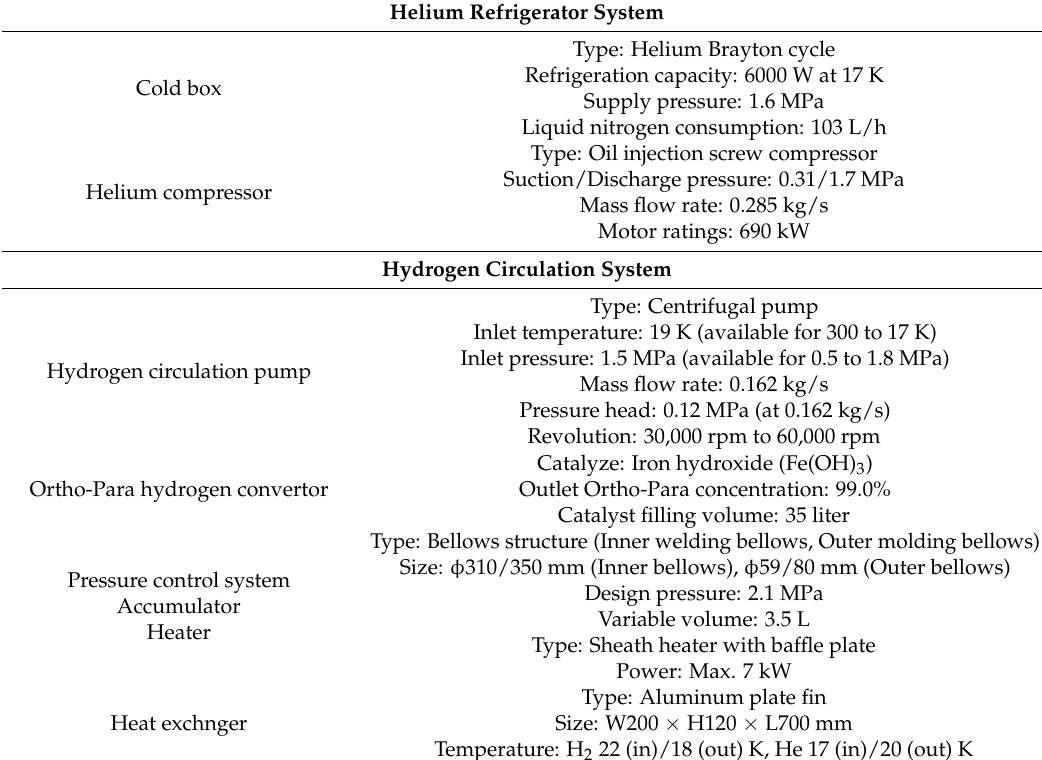
Table 4. Specifications for main components of the cryogenic